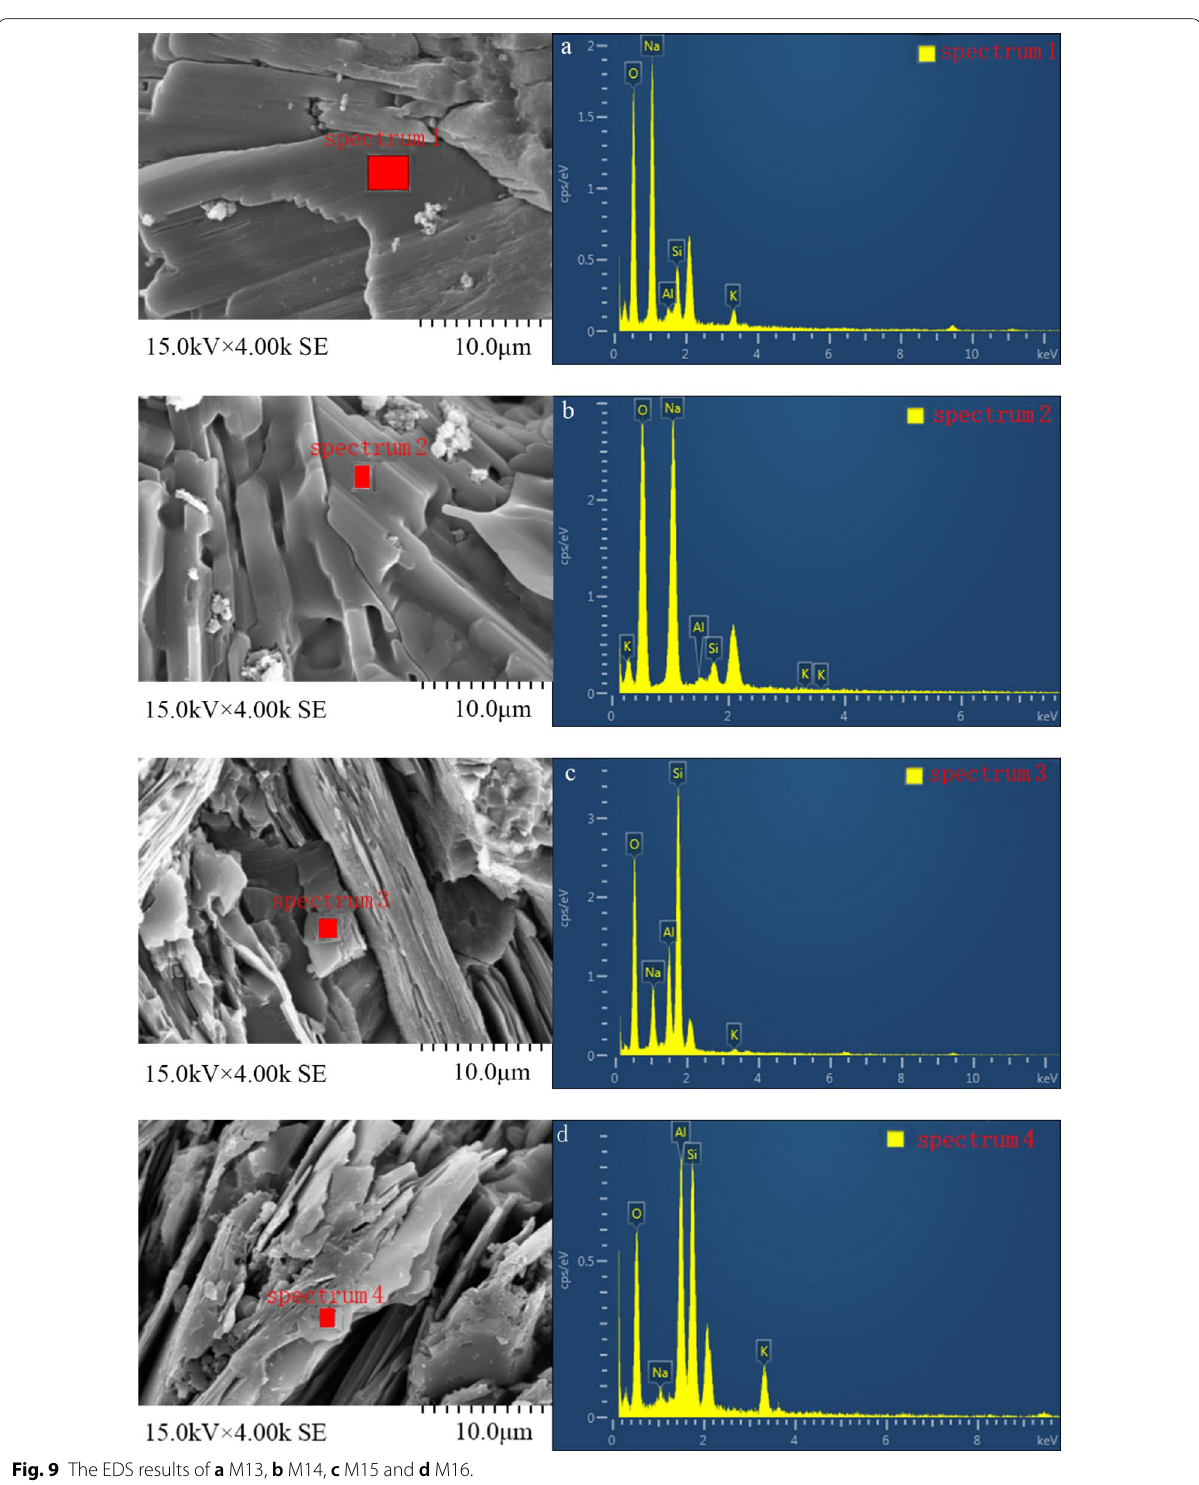
Fig. 9 The EDS results of a M13, b M14, c M15 and d